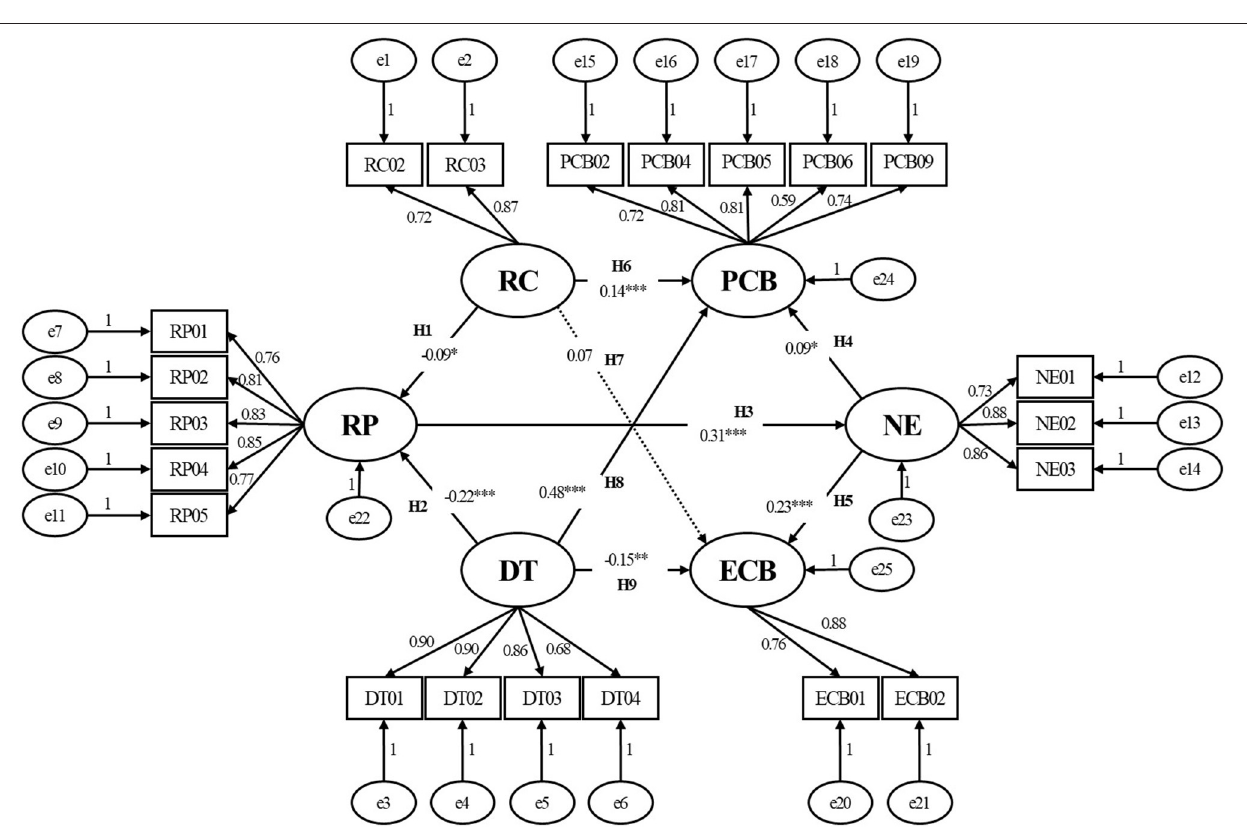
FIGURE 2 | Model 1: Preliminary fit results of the theoretical model. * p < 0.05; ** p < 0.01; *** p < 0.001. RC, risk communication; DT, degree of trust; RP, risk perception; NE, negative emotions; PCB, protective coping behavior; ECB, excessive coping behavior. The variables e1, e2,..., e25 represent the structure